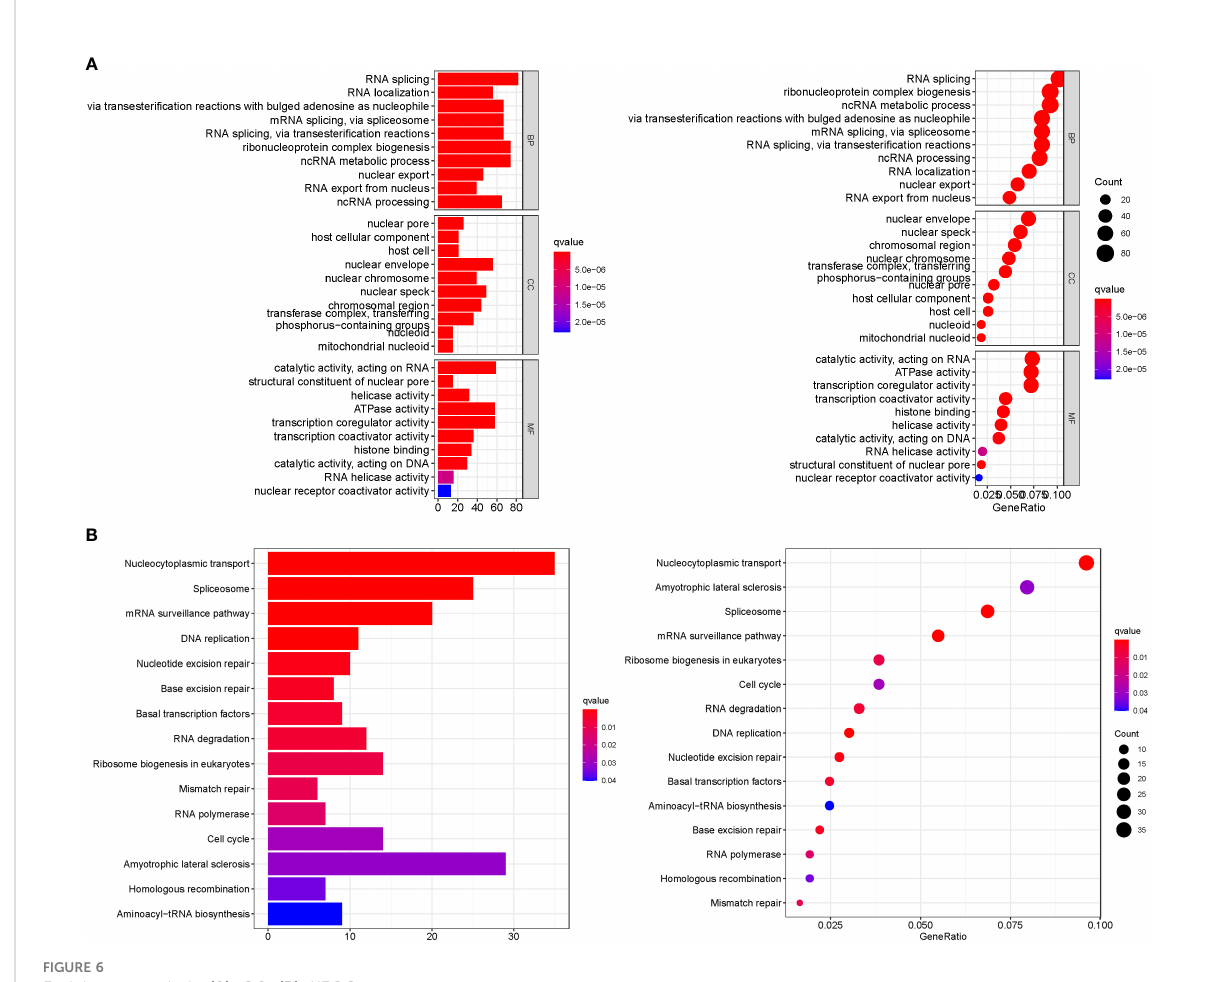
FIGURE 6 Enrichment analysis. (A) : GO. (B) :